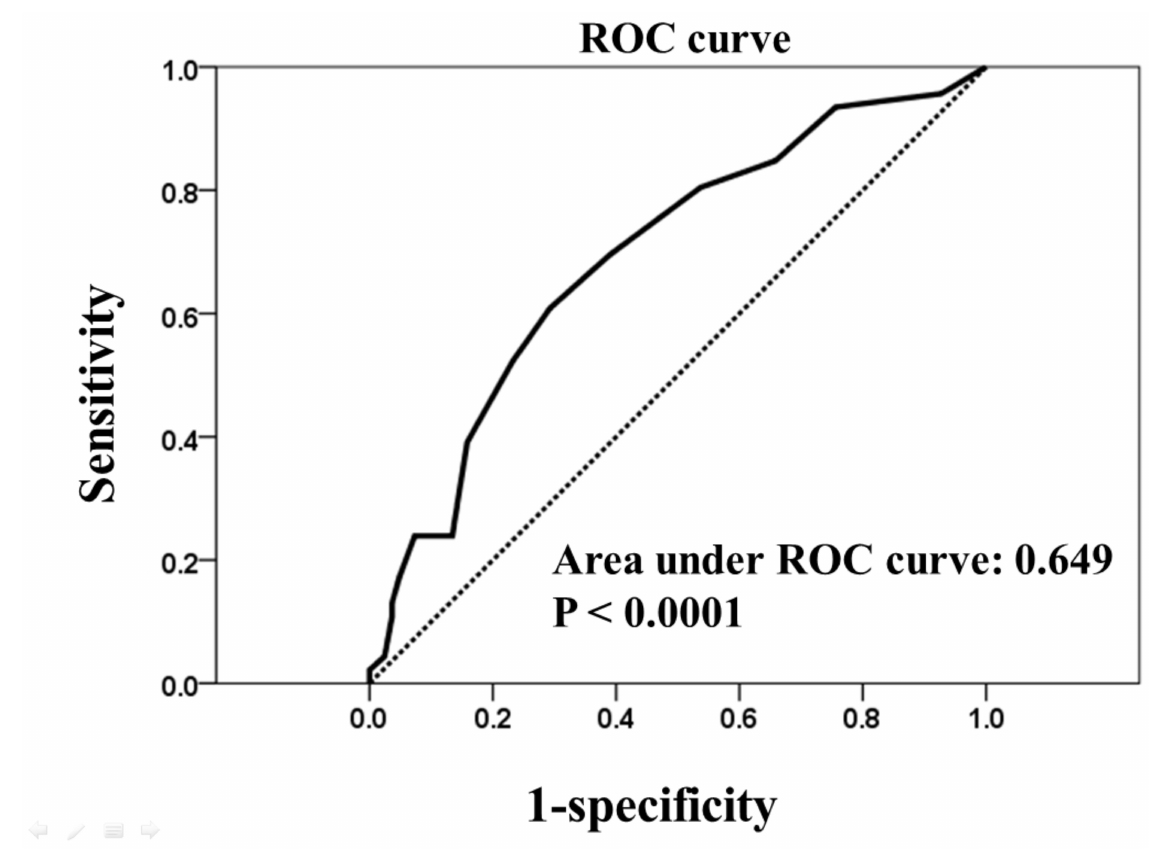
Figure 2. Receiver operator characteristic (ROC) curve for patient-generated subjective global assessment (PG-SGA) compared with outcomes (favorable outcome vs. fatal outcome). The 45 ◦ line represents the curve for an ROC area of 0.5. The area under the curve (AUC) is 0.649; 95% confidence interval: 0.530–0.767, thus indicating the PG-SGA score. Table 3. Risk factors for fatal